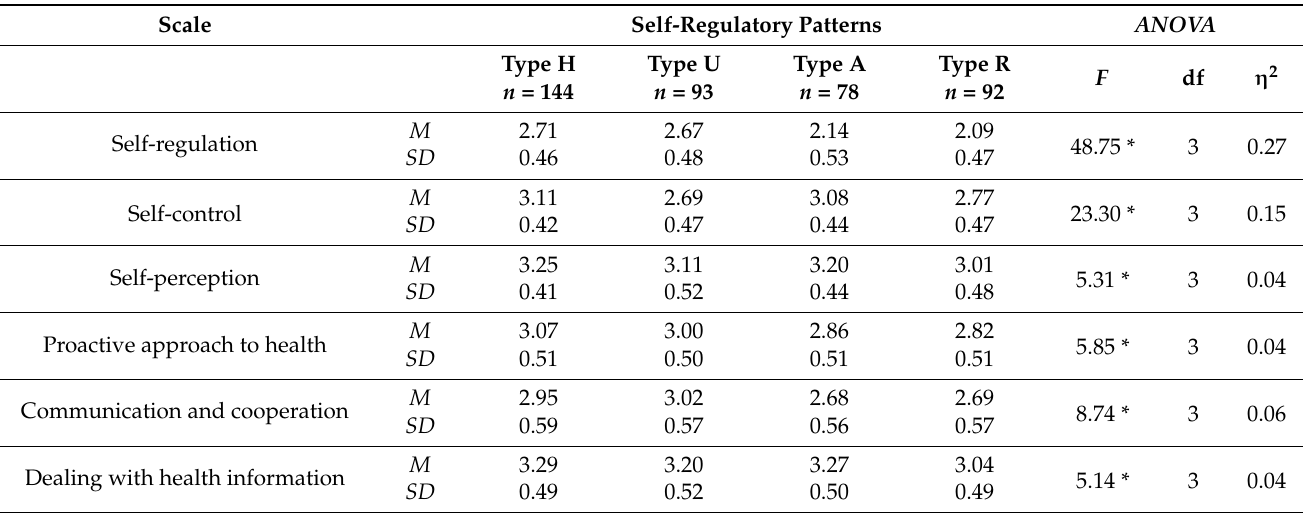
Table 4. Mean differences between the four self-regulatory patterns on health literacy: Results of analysis of variance